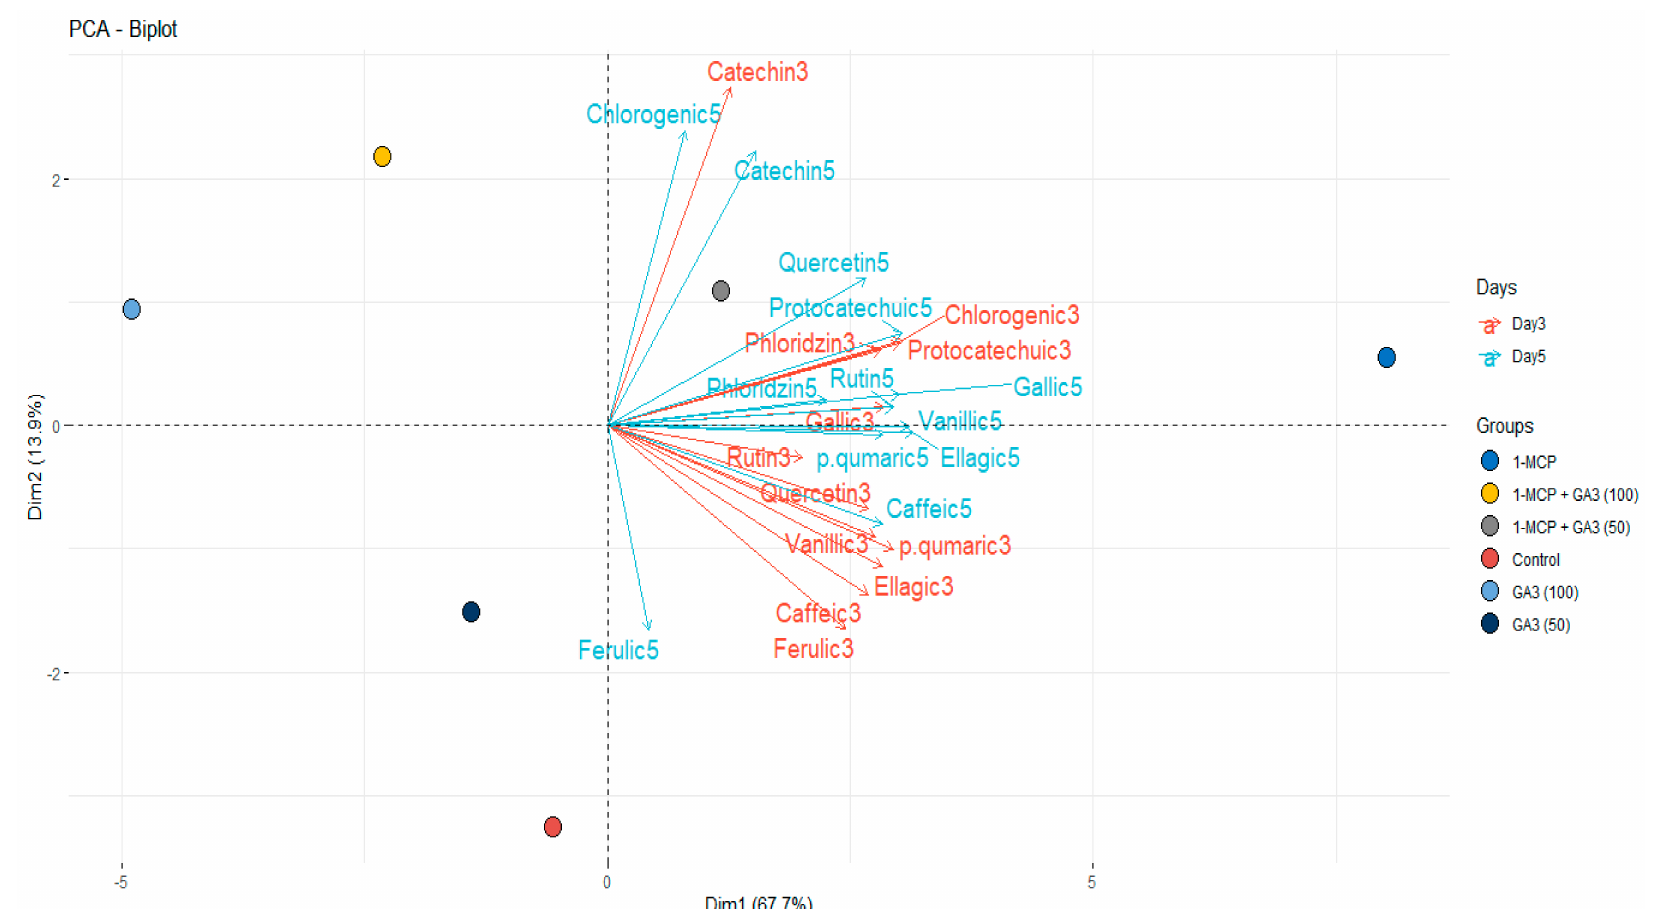
Figure 2. Distribution of phenolic compound contents of strawberry fruits during its